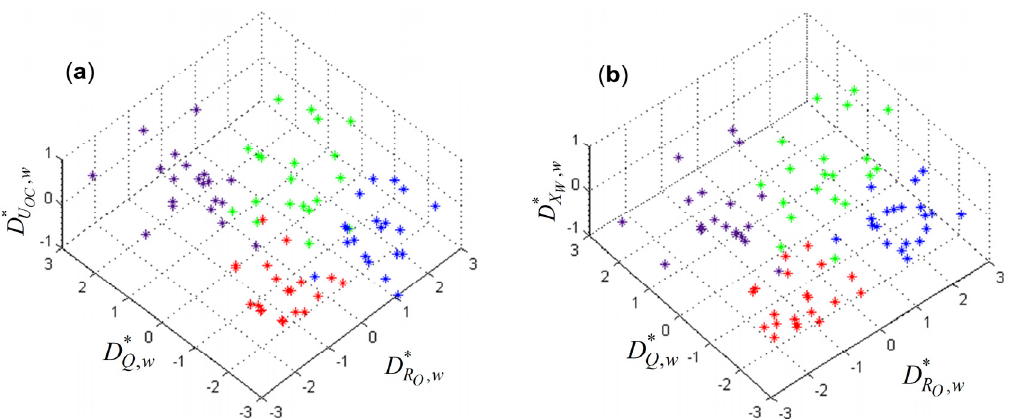
Figure 12. Battery feature vector clustering result ( a ) Clustering result from the view of